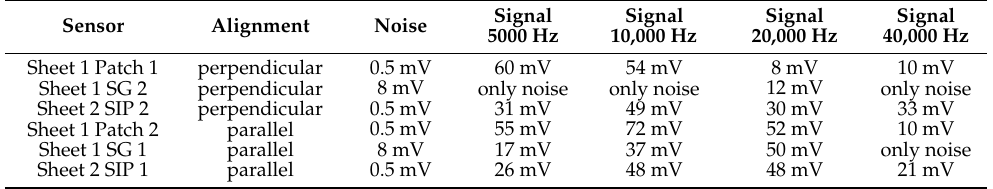
Table 4. Values of the noise and the measured signal for an excitation with 5, 10, 20 and 40 kHz.